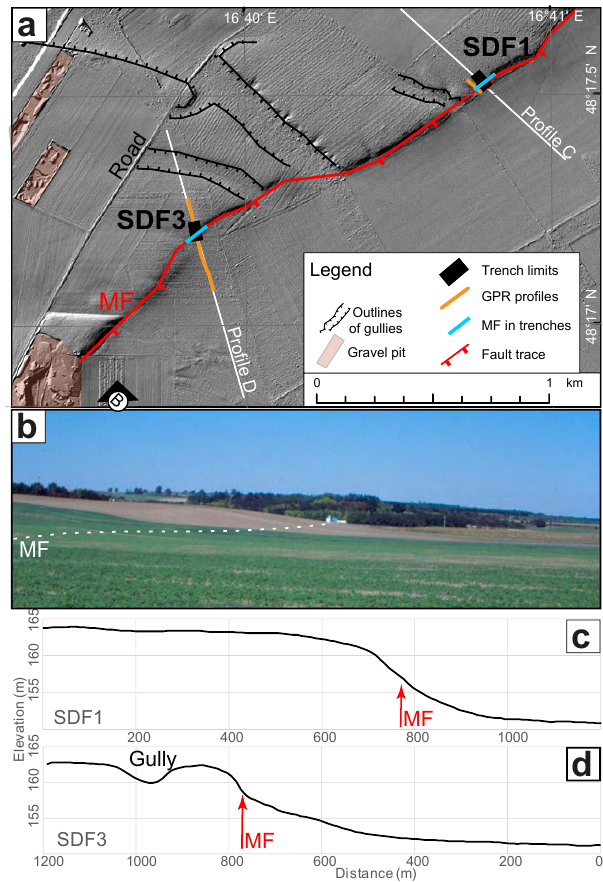
Figure 4. Trench locations of SDF1 and SDF3. (a) Locations of trenches SDF1 and SDF3 relative to the Markgrafneusiedl Fault (MF) and the margin of the Gaenserndorf terrace NW of the MF. Gullies normal to the MF are currently dry valleys resulting from Pleistocene drainage of the terrace. This lidar image with 1 × 1m resolution was provided by the government of Lower Austria. (b) View of the fault scarp south of the forested area where the trenches are located, looking towards N. The assumed fault trace of the MF is marked by the white dashed line. Approximate viewpoint is marked in panel (a) by white circle. ( c and d ) Topographic pro- files across the fault scarp of the MF at trench locations SDF1 and SDF3, respectively. Vertical exaggeration: 16 × . See profile loca- tions in panel (a)